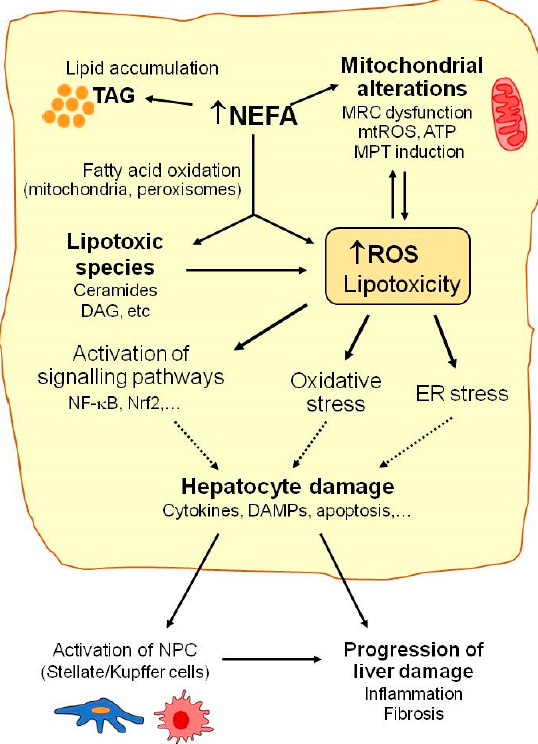
Figure 1. Mechanisms implicated in NAFLD. Many molecular pathways contribute to NAFLD development. When the liver’s capacity to control energy substrates is overwhelmed, toxic lipid species may accumulate. This can be associated with increased reactive oxygen species (ROS) production, mitochondrial injury (mitochondrial respiratory chain (MRC) alterations, increased mitochondrial ROS (mtROS), or mitochondrial membrane permeability transition (MPT) induction), hepatocellular stress, and liver injury. Excessively high non esterified fatty acid (NEFA) levels enhance triacylglycerides’ (TAG) accumulation and fatty acid oxidation in hepatocytes and favor ROS generation, which may contribute to alterations in mitochondrial function and metabolic energy homeostasis in hepatocytes. Accumulation of lipotoxic species (e.g., ceramides, diacylglycerol (DAG)) may aggravate mitochondrial dysfunction and contribute to ROS overproduction, oxidative stress, endoplasmic reticulum (ER) stress, and activation of the signaling pathways involved in hepatocyte injury, including the release of cytokines or damage-associated molecular patterns (DAMPs). Finally, activation of non-parenchymal cells (NPC) by oxidative stress or by the signals released by damaged hepatocytes may contribute to NAFLD progression.